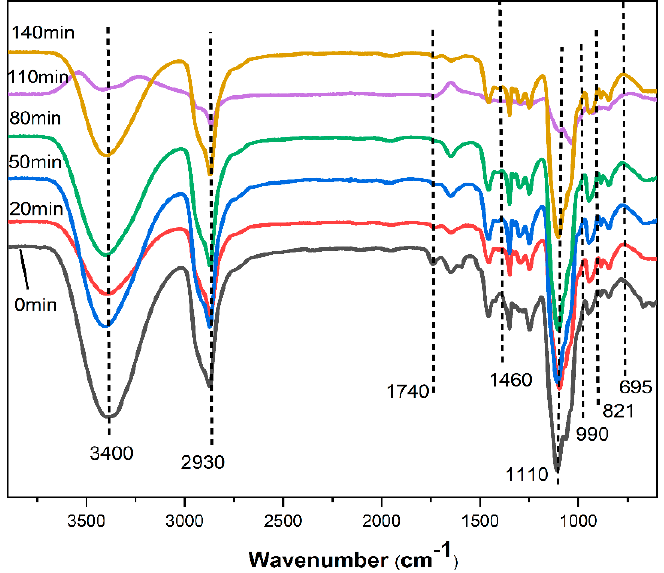
Figure 1. FT-IR of liquefied products at different liquefaction times.